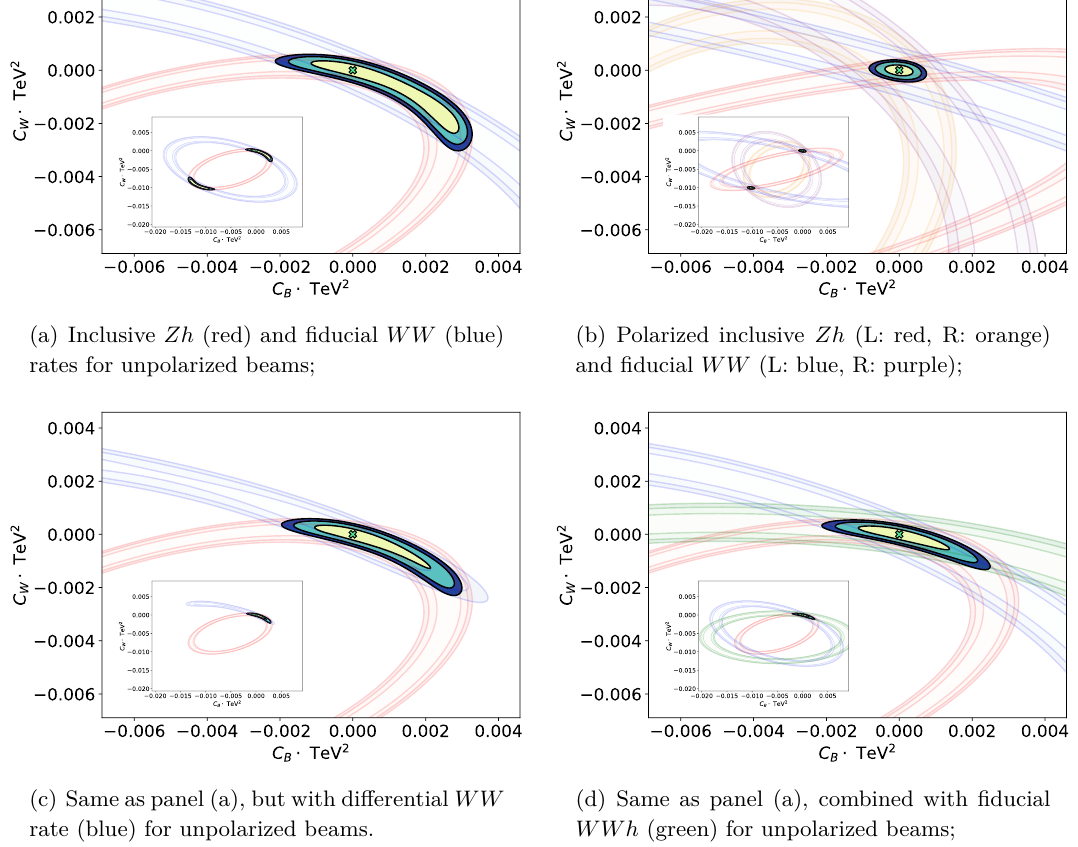
Figure 10 . Same as figure 4, but for E cm = 14